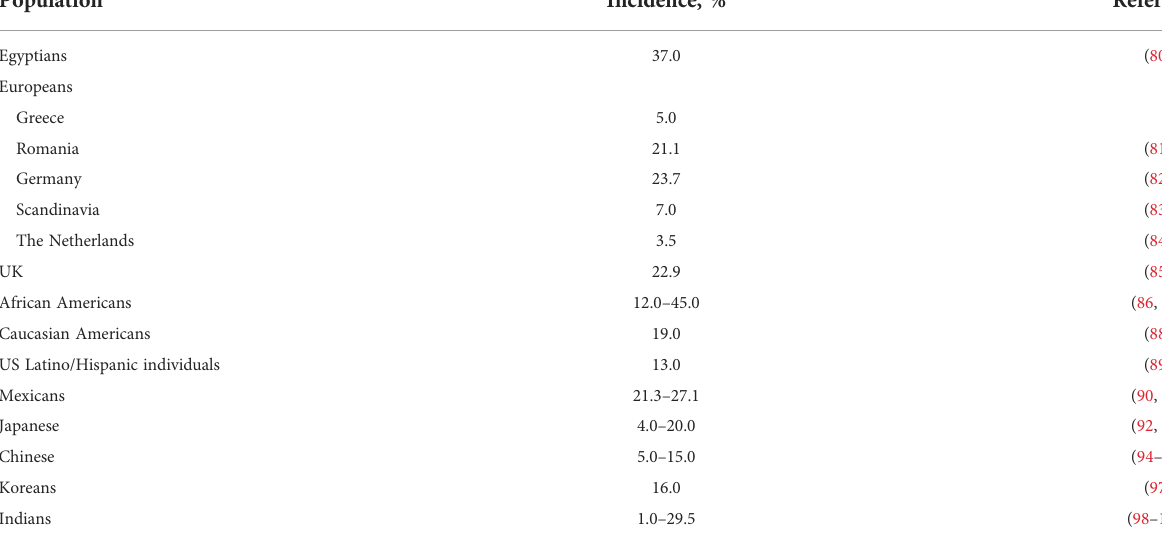
TABLE 3 Incidence of MSI-H/dMMR colorectal cancer in different